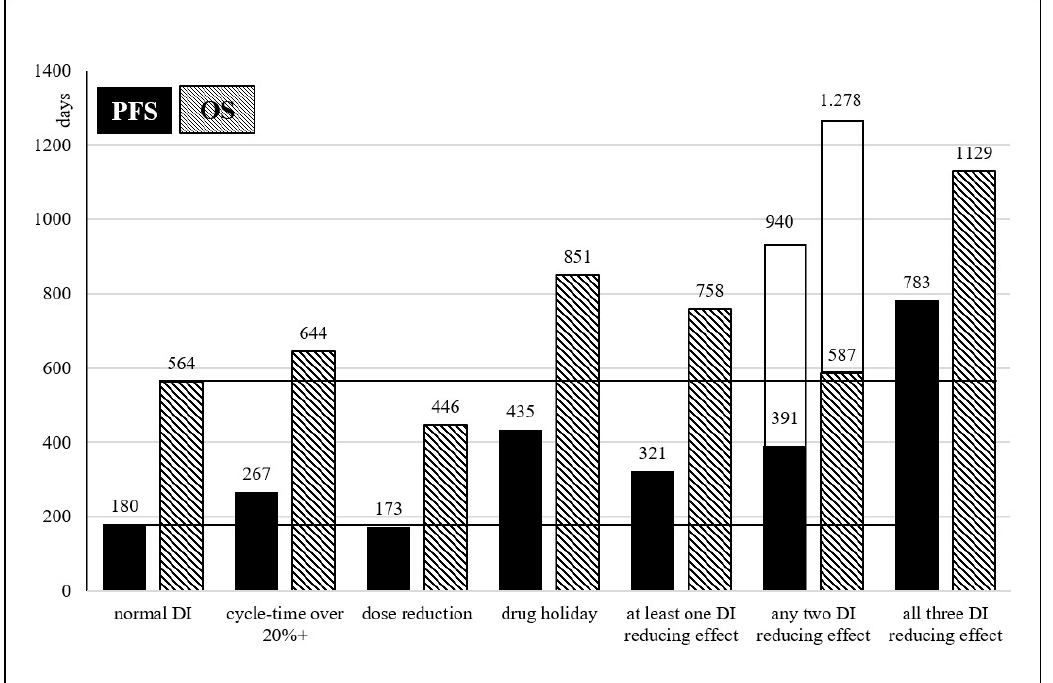
Figure 1. PFS/OS changes due to different DI reducing effects, separately and in combination, compared to the results of unmodified treatments.